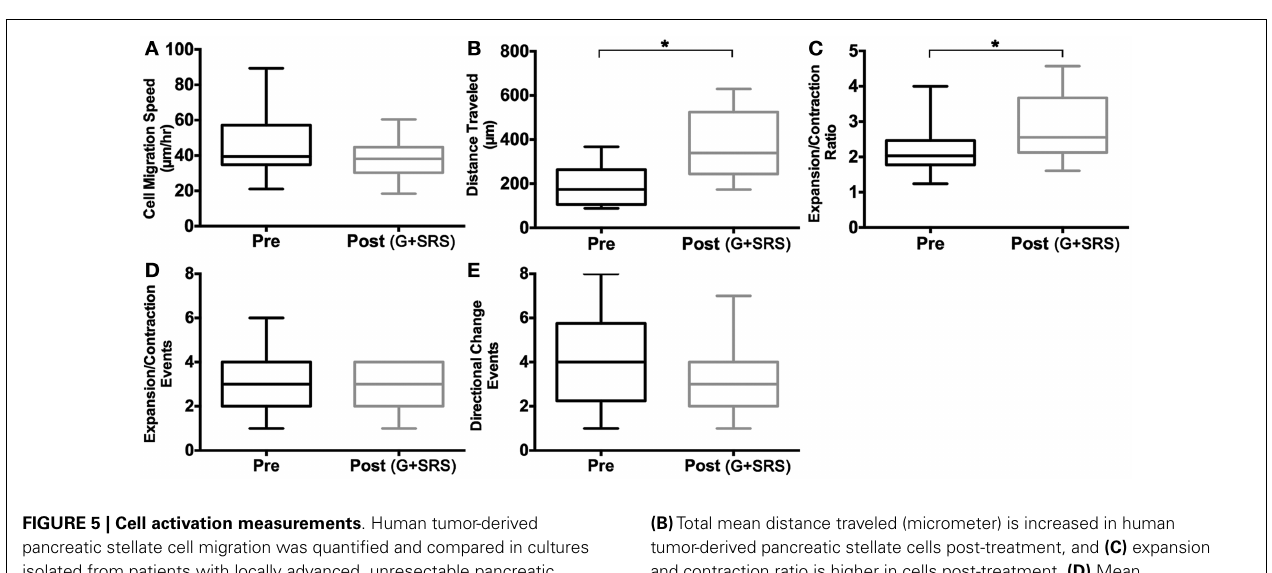
FIGURE 5 | Cell activation measurements . Human tumor-derived pancreatic stellate cell migration was quantified and compared in cultures isolated from patients with locally advanced, unresectable pancreatic adenocarcinoma before treatment (Pre) and at 6months following treatment with gemcitabine (G) and stereotactic radiosurgery (SRS) (Post). Box plots comparing (A) mean cell speed (micrometer per hour) show no significant rate of change of position when traveling in culture.